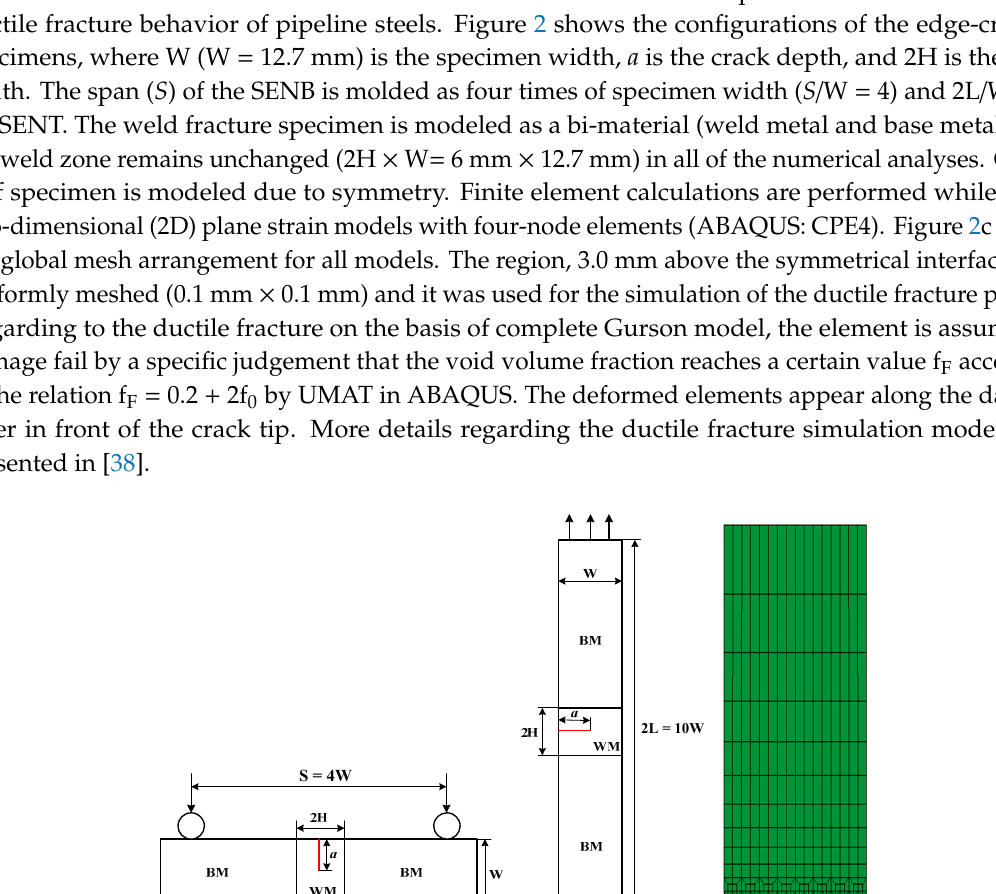
( b ) Figure 3. Schematic plots of pipe, ( a ) inner-cracked pipe; ( b ) schematic illustration of axisymmetric model.